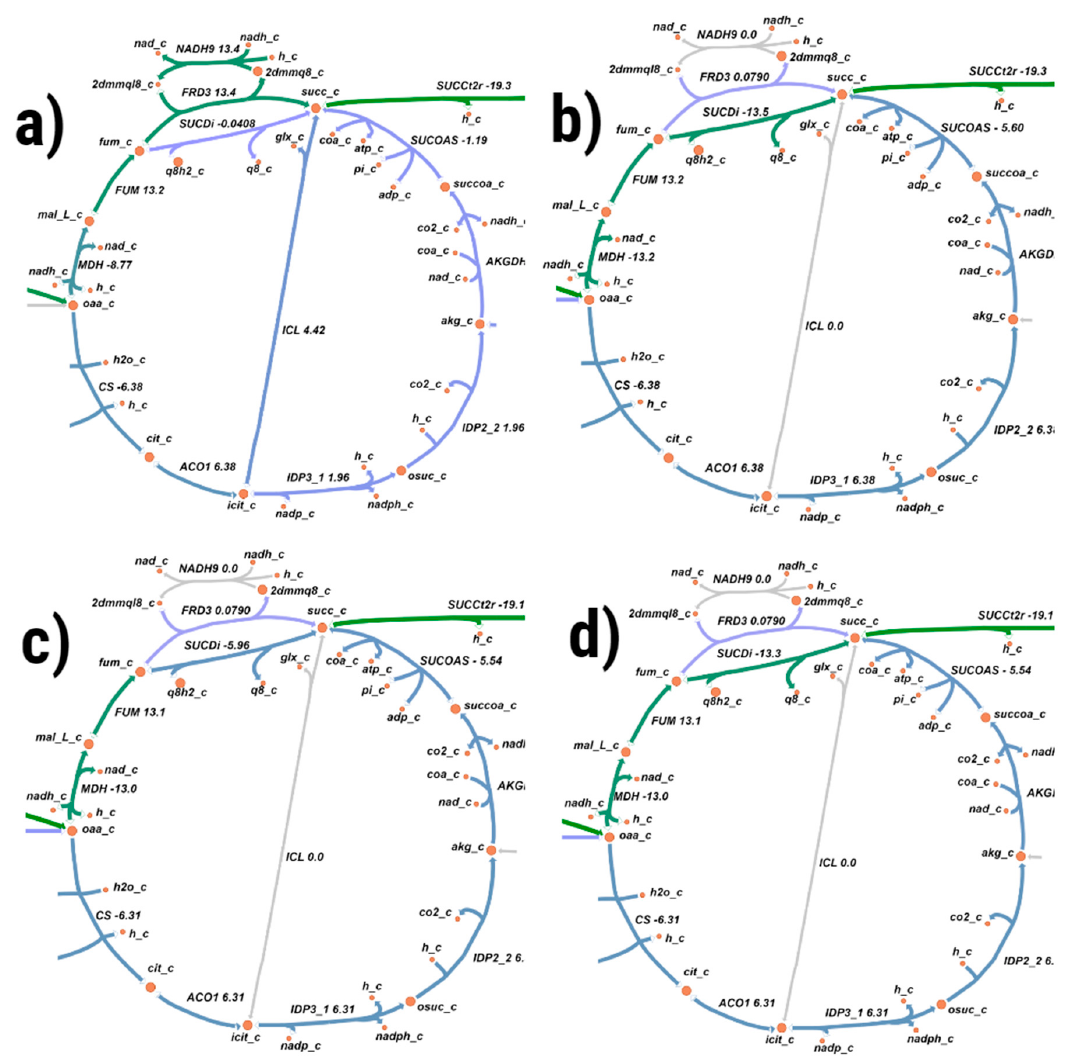
Figure 1. The flux distribution maps for TCA cycle predicted by iMK1321 for growth of Geobacillus icigianus on: ( a ) glucose, ( b ) glycerine, ( c ) xylose, ( d ) arabinose. The maps were drawn in Escher web-tool, where the circles represent metabolites, while the arrows refer to reactions [27]. The flux value through the reaction is reflected by colour, where numbers represent corresponding range of the reaction fluxes in mmol gDCW − 1 h − 1 : purple—0–1; blue—5–10; green—10–30; red—30–80 mmol gDCW − 1 h − 1 .